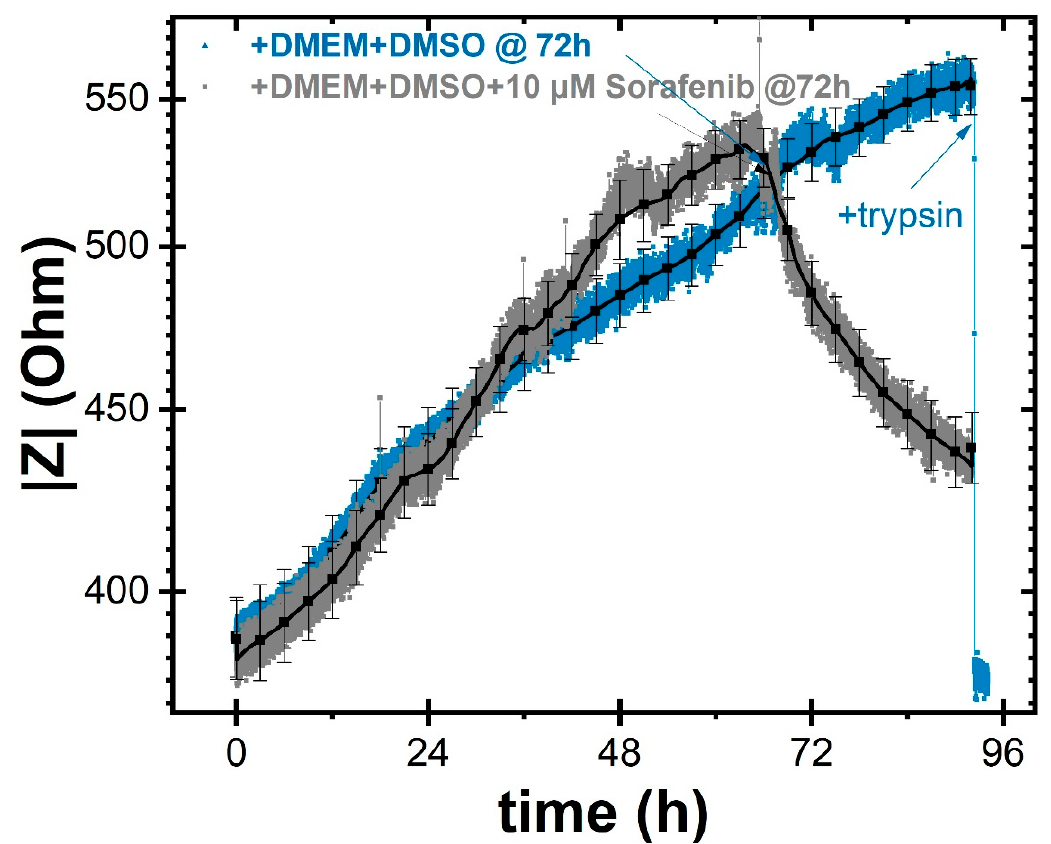
Figure 5. Evaluation of the effect of DMSO solvent (blue curve) and a 10 µ M Sorafenib solution (gray curve) on cell proliferation upon administration about three days after cell seeding. Black curves show mean ± standard deviation from statistical analyses.